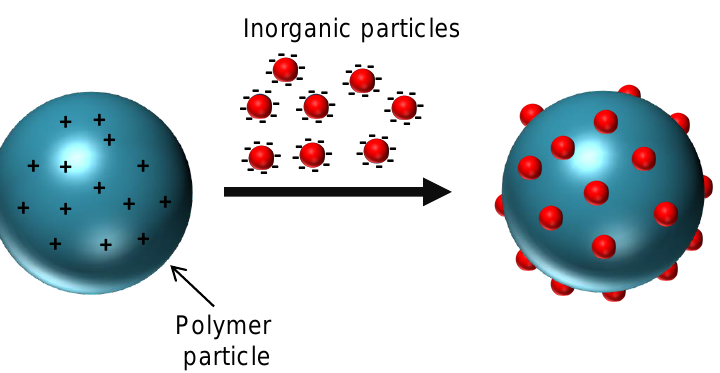
Figure 5. Heterocoagulation of oppositely charged